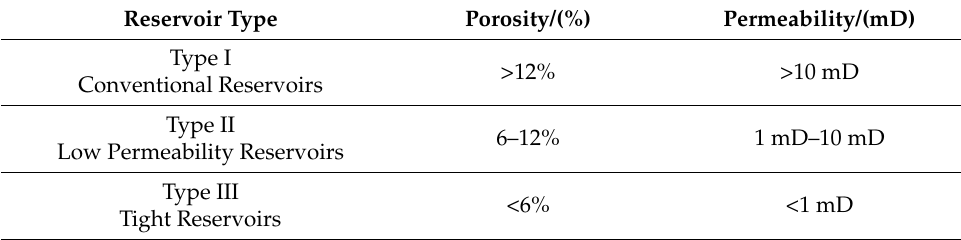
Table 3. The reservoir classification standards